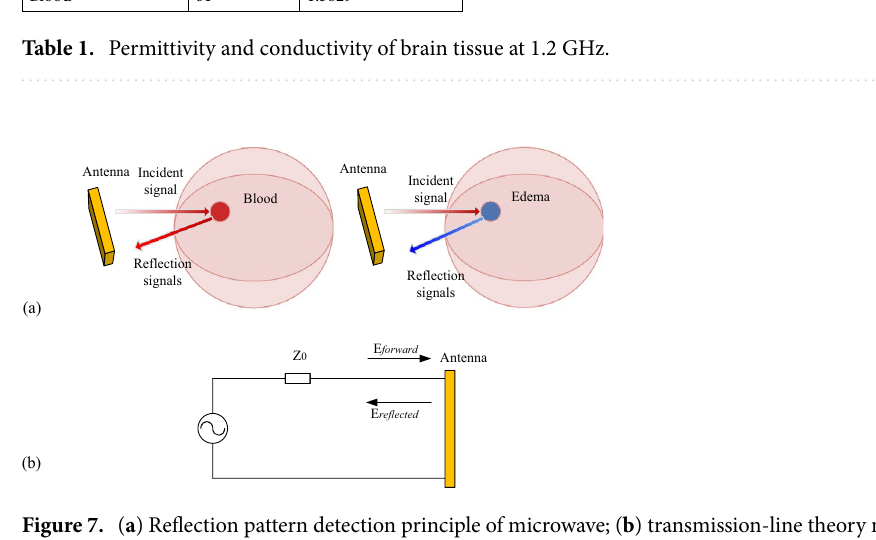
Figure 7. ( a ) Reflection pattern detection principle of microwave; ( b ) transmission-line theory model of